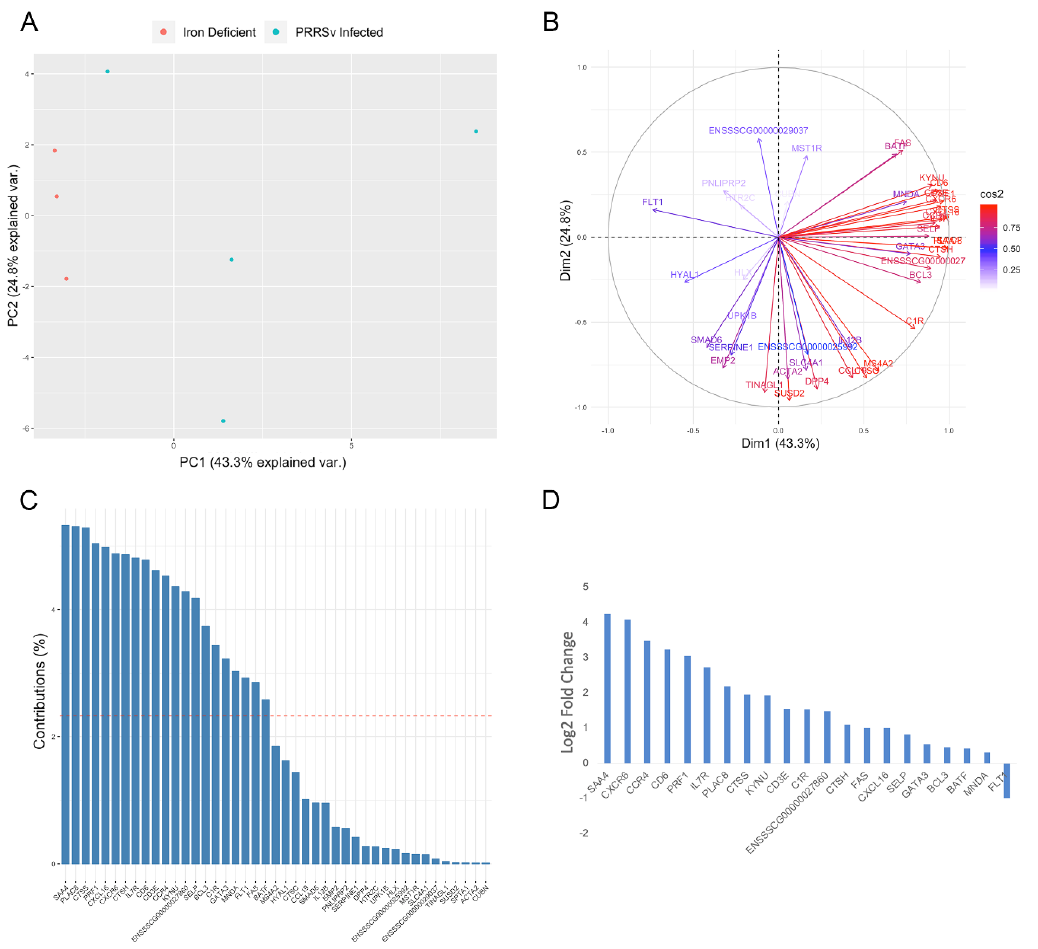
Figure 3. Contribution of immune related DEGs to reduced cognition group variation. ( A ) PCA based on the expression level of 43 immune related DEGs. ( B ) Breakdown of variables contributing to each principle component. ( C ) Percent contribution of each gene to principle component 1 (PC1). The red dotted line signifies the expected contribution of each gene, and any genes contributing at a higher rate were considered significant contributors. ( D ) Sixteen DEGs contributing to PC1 displayed a log2 fold change differences >1 or <−1. Log2 fold changes represent expression levels in the PRRSv infected compared to iron deficient group.